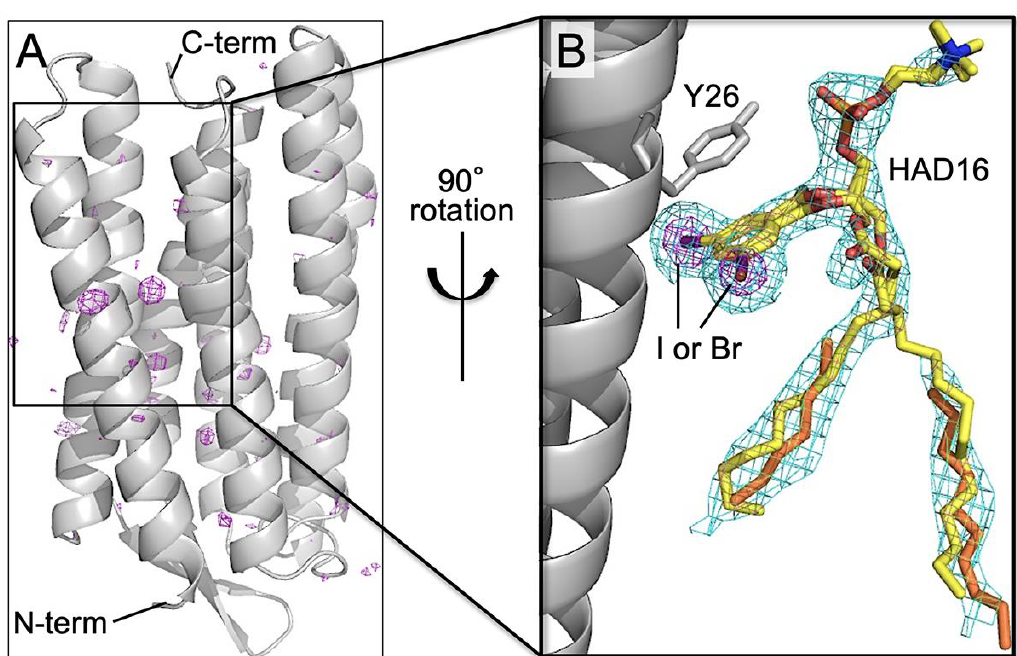
Figure 8. Structure of bacteriorhodopsin in complex with HAD16. ( A ) Final refined structure (gray ribbon model) after structure determination by molecular replacement. Anomalous difference map (purple mesh; contoured at 4.0 σ ) is also shown. ( B ) Close-up view of the HAD16 binding site in the final refined structure with 2m F o –D F c map (cyan mesh; 1.0 σ ). The C, N, O, I, and Br atoms of HAD16 (stick models), which is assigned as alternative conformations, are colored yellow, blue, red, purple, and brown, respectively. Alkyl chains derived from native lipid or DMPC/CHAPSO bicelles are depicted as orange stick